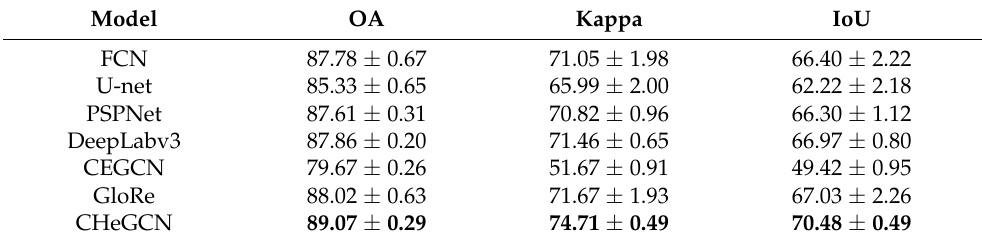
Table 3. Quantitative comparison of different methods in the Beijing